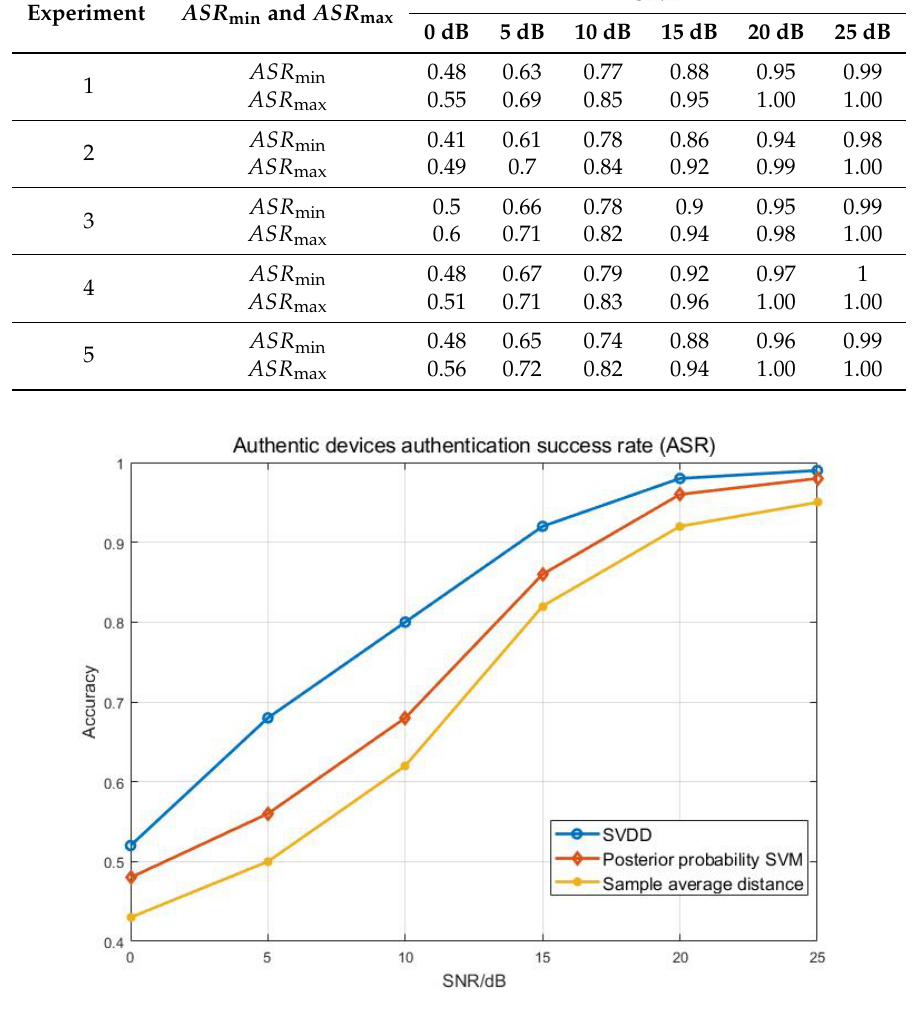
Figure 8. Authentic devices authentication success